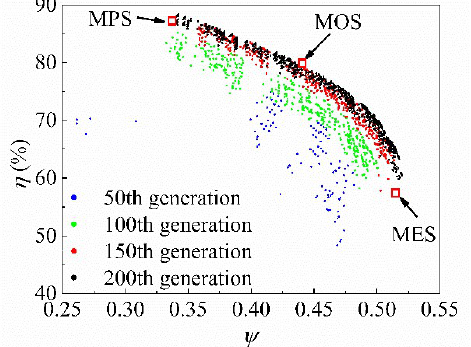
Figure 12. The Pareto front shape of different generations.